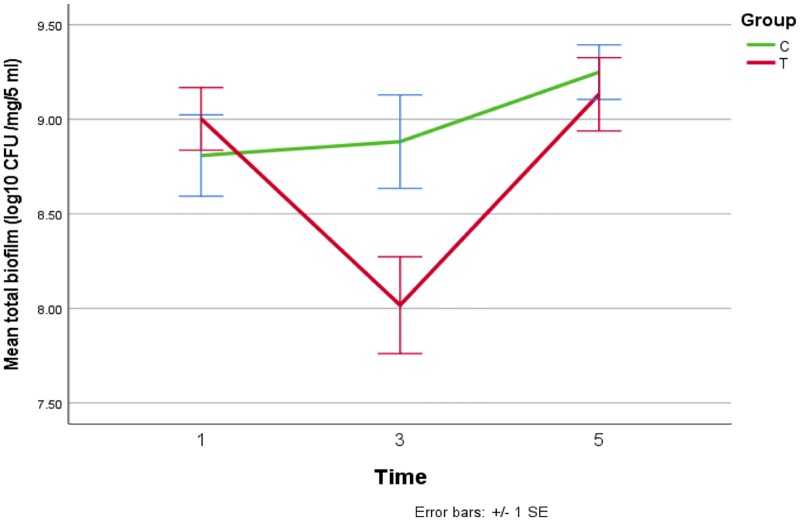
Effect of GIC containing tt-farnesol on viability of biofilm of S. mutans expressed as average values for log10 of the numbers of CFU/milliliter versus day of treatment. T–GIC + tt-farnesol; C- GIC (control).